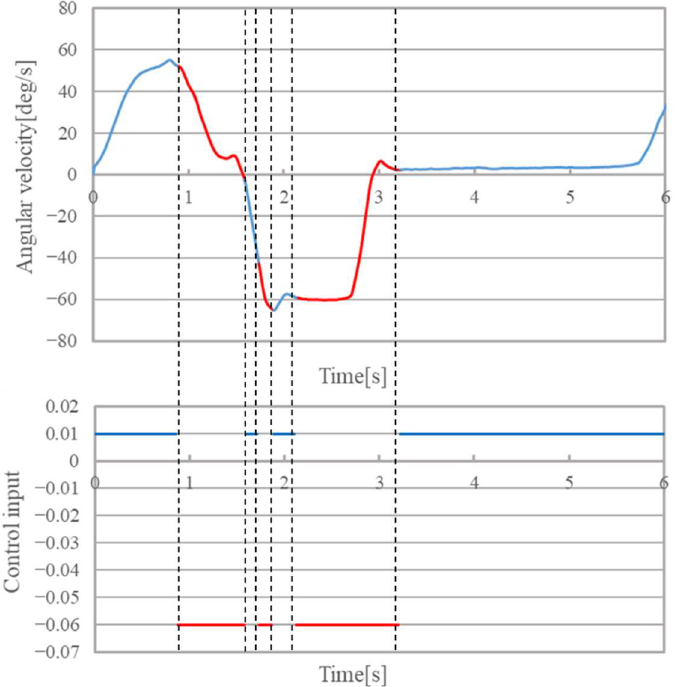
Figure 14. Time history of angular velocity and control input (experimental results).